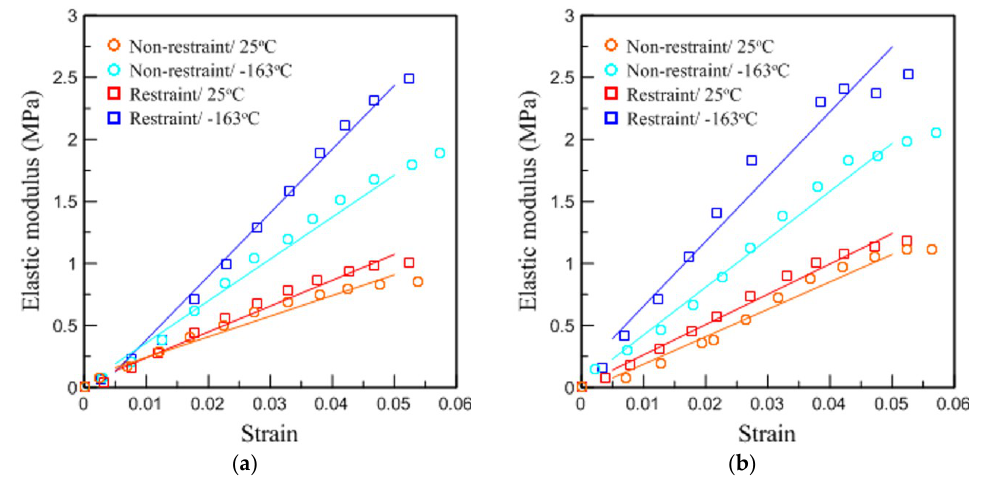
Figure 10. Compressive stress–strain curves for ( a ) pure PUF and ( b ) RPUF according to the environmental conditions of the restraint system.